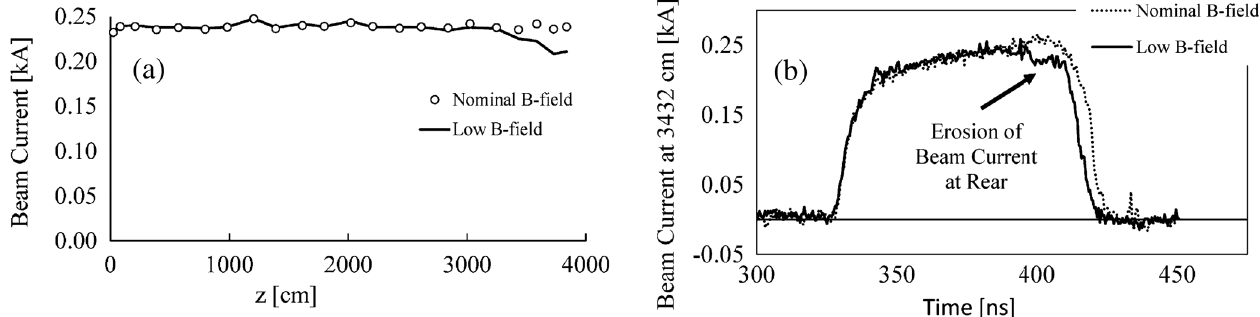
FIG. 5. (A) Beam current measurements along the length of the accelerator for nominal (dots) and low (solid line) magnetic guide fields. (B) Raw data from the nominal (dots) and low (solid line) magnetic guide field cases shows erosion of the beam current from the rear of the low field pulse which is indicative of the BBU